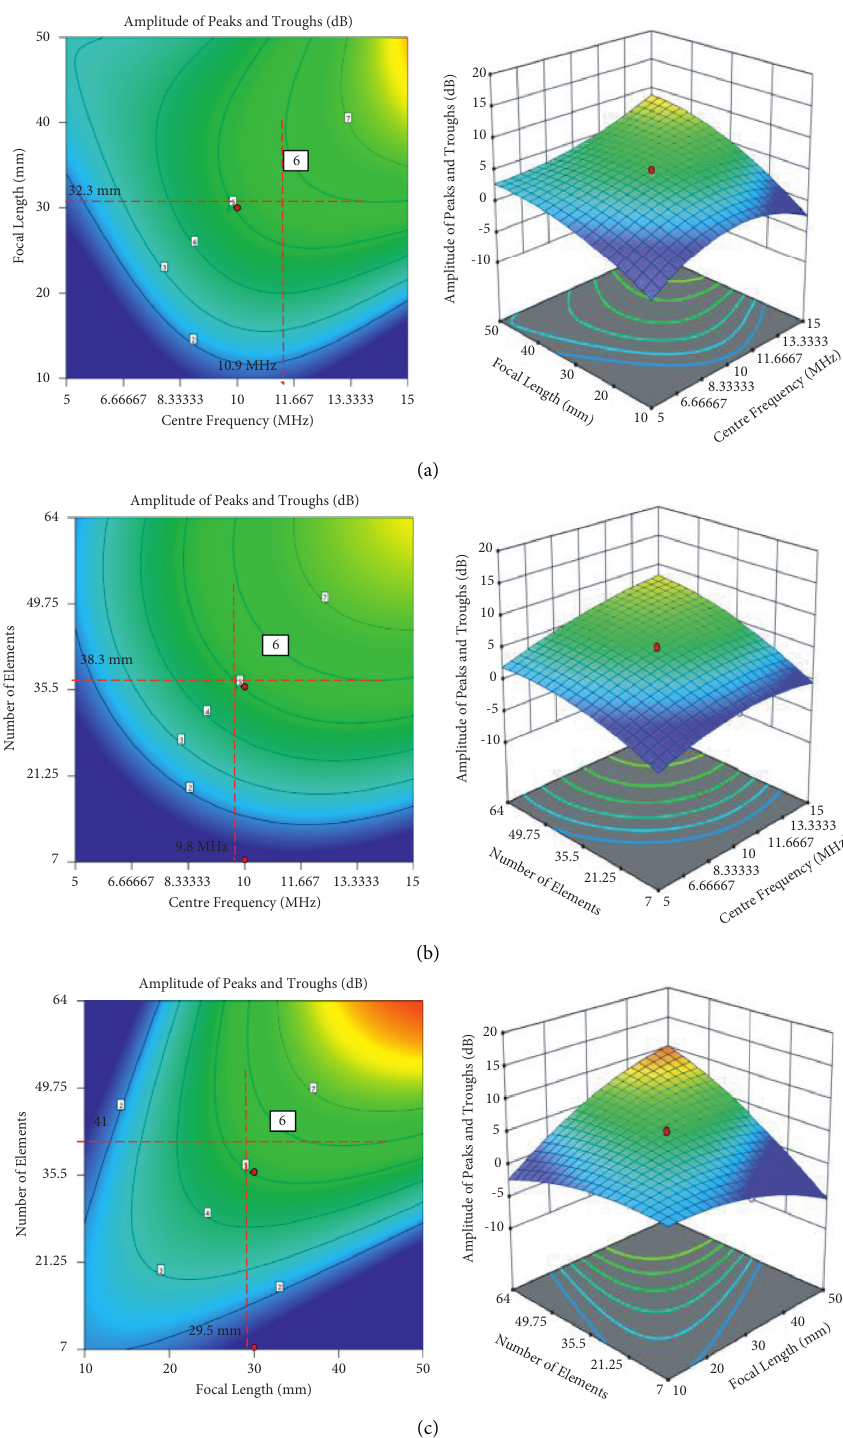
Figure 4: Interaction of center frequency, focal length and element number of the transducer on amplitude difference (Response surface plot and contour plot): (a) number of elements is 36; (b) focus length of 30mm; (c) Transducer frequency of